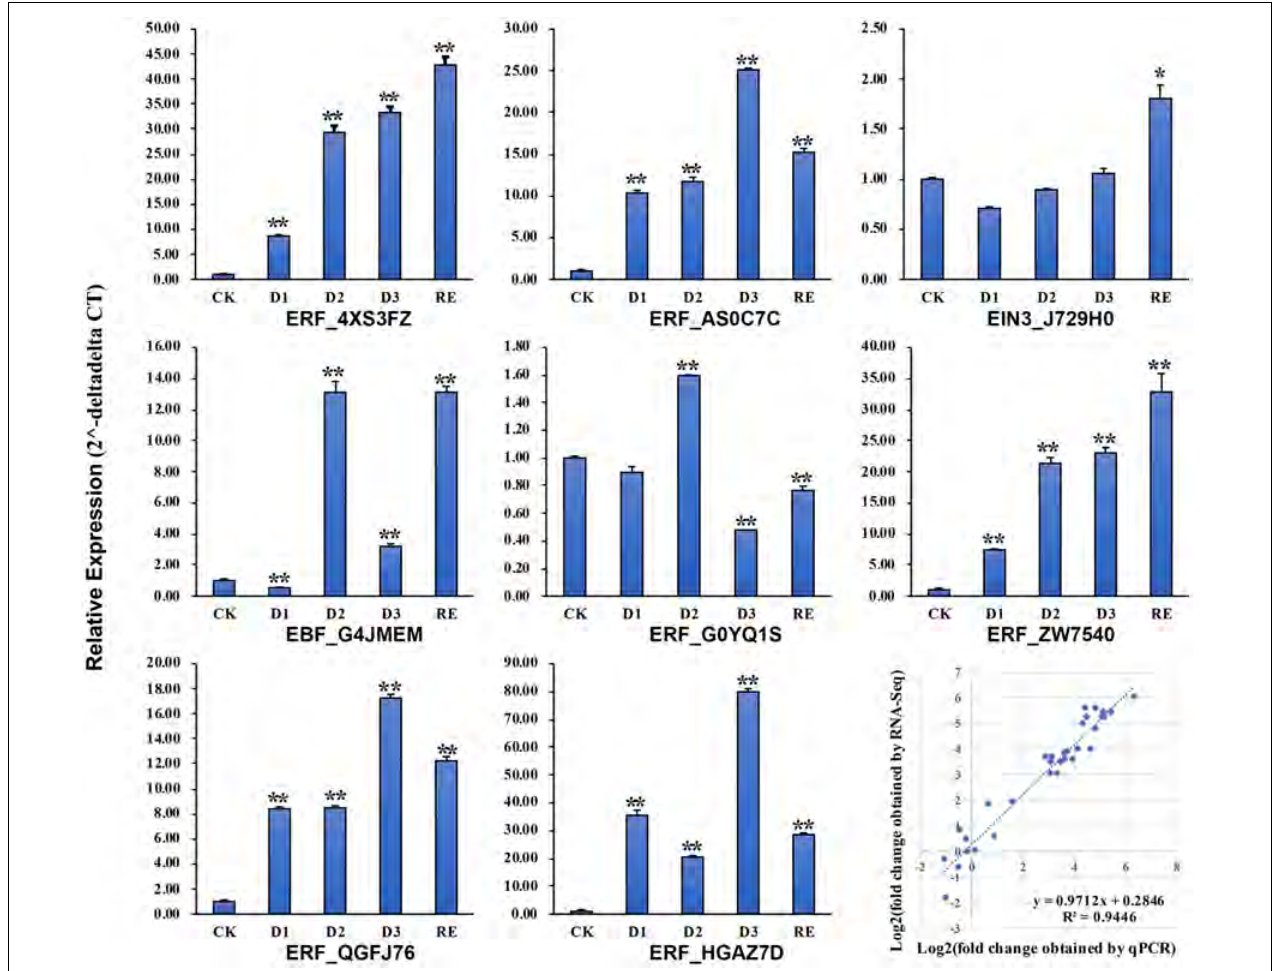
FIGURE 9 | Validation of the RNA sequencing (RNA-Seq) results by real-time quantitative PCR (qRT-PCR). *, **Significantly different at p ≤ 0.05 and 0.01, respectively.